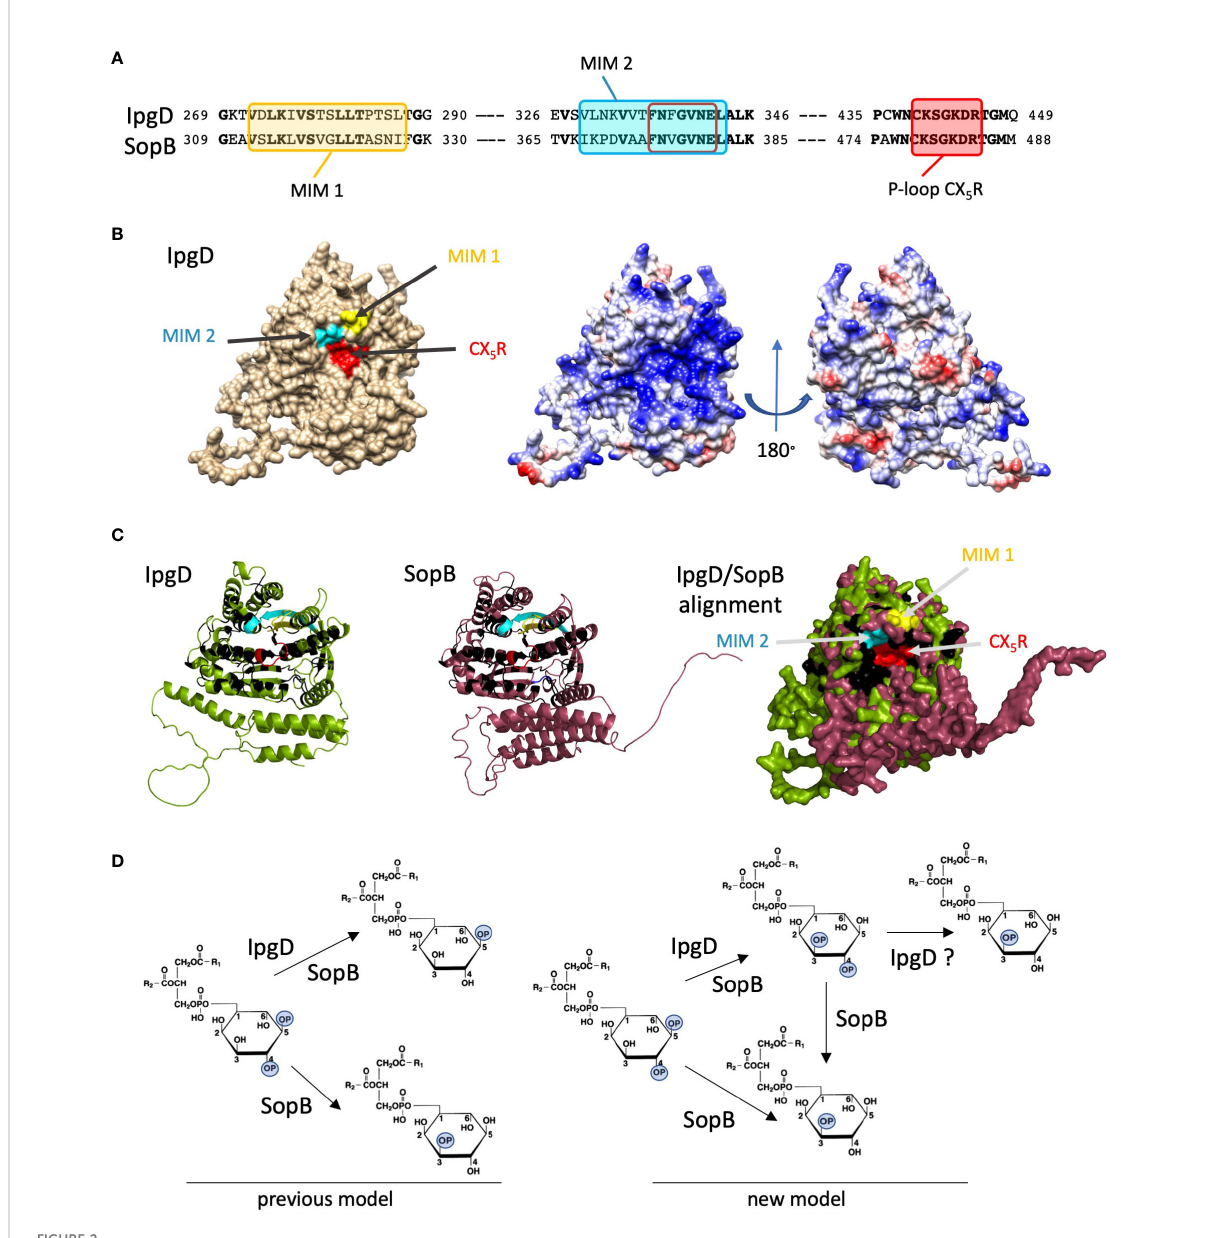
FIGURE 2 Conservedphosphoinositidephosphatasefeaturesof Shigella IpgDand Salmonella SopB. (A) SequencealignmentsofMIMsandP-loopmotivesinIpgDand SopB.Boldcharacters:conservedresidues.Yellowbox:MIM1,bluebox:MIM2,redbox:P-loop.TheMIMswereidenti fi edexperimentallyandthrough computationallearning,approaches(seetext). (B) Left:Alphafold-based insilico 3DstructureanalysisofIpgD(Jumperetal.,2021)followedbyPyMOL molecularvisualization(SchrödingerandDeLano2020)showingtheP-loopandsurroundingMIMs.Right:surfacechargedistribution.Blue:positivecharges, red:negativecharges. (C) HighstructuralhomologiesbetweenIpgDandSopB.Green:IpgD,purple:SopB,yellow:MIM1,cyan:MIM2,red:P-loop,black: conservedaminoacids.LeftandMiddle:Alphafold-based3DstructuresofIpgDandSopB.Right:overlaid3Dstructuresshowingtheirhighhomology. (D) EnzymaticreactionsofIpgDandSopB.PI(4,5)P 2 dephosphorylationeitheryieldsPI5PforbothenzymesorPI3PinthecaseofSopB(left).Therecentlydescribed phosphotransferaseactivityleadstoPI(3,4)P 2